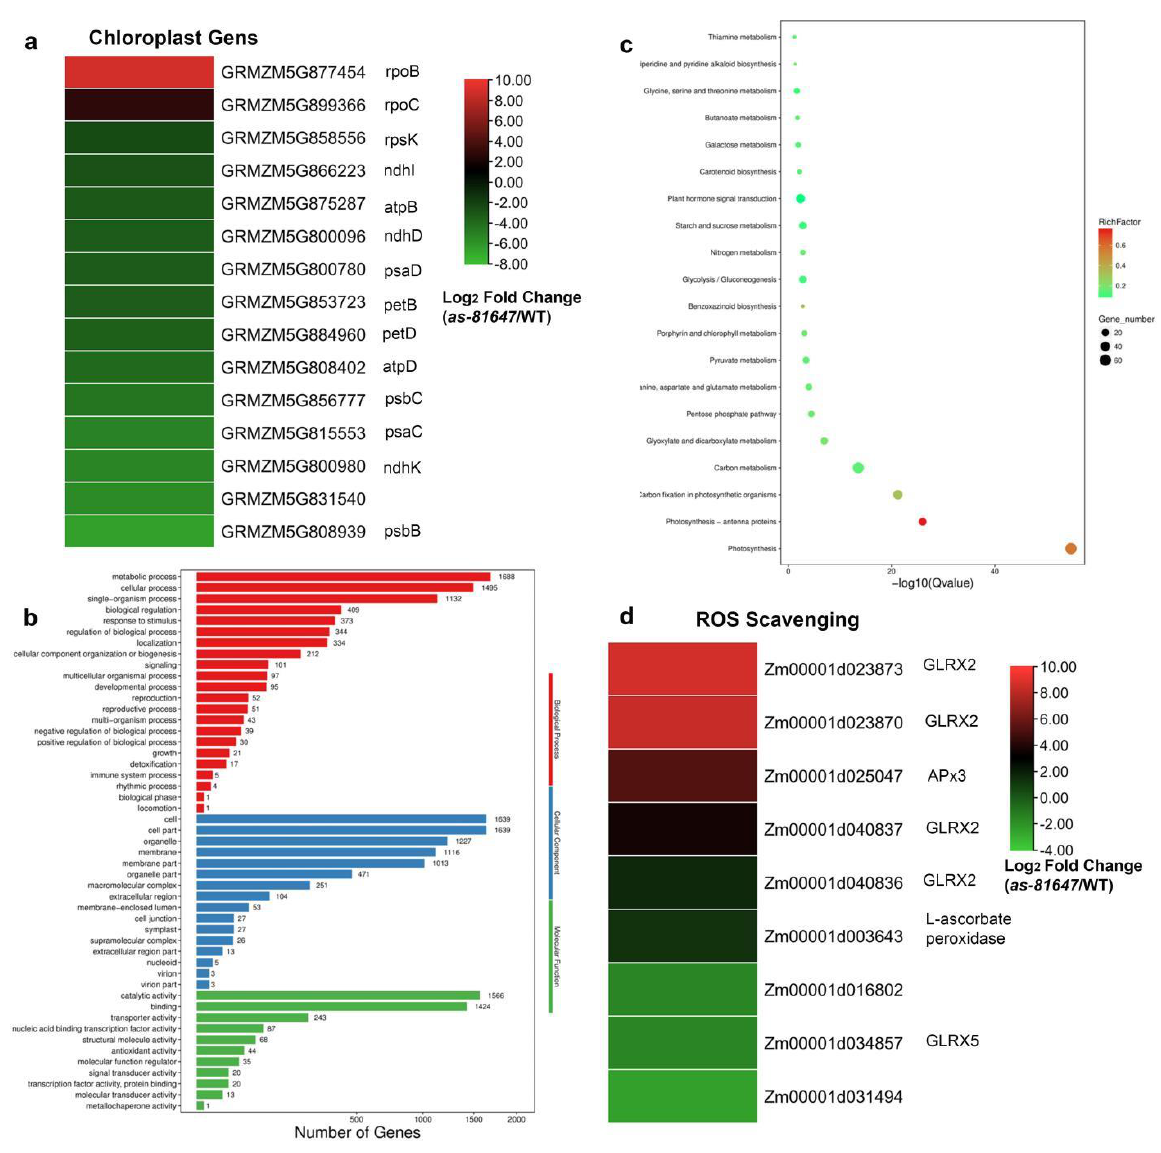
Figure 6. RNA-seq analysis of WT and as-81647 . ( a ) Heat maps of differentially expressed chloroplast genes. ( b ) The most significantly related GO terms of the functional annotated DEGs, p < 0.05. biological process (Red box), cellular components (Blue box), and molecular functions (Green box). The x-axis represents gene number and the y-axis represents the GO terms name. ( c ) The top 20 enriched KEGG pathways. The x-axis represents the Q − value and the y-axis represents the pathway name. ( d ) Heat maps of differentially expressed genes involved in ROS